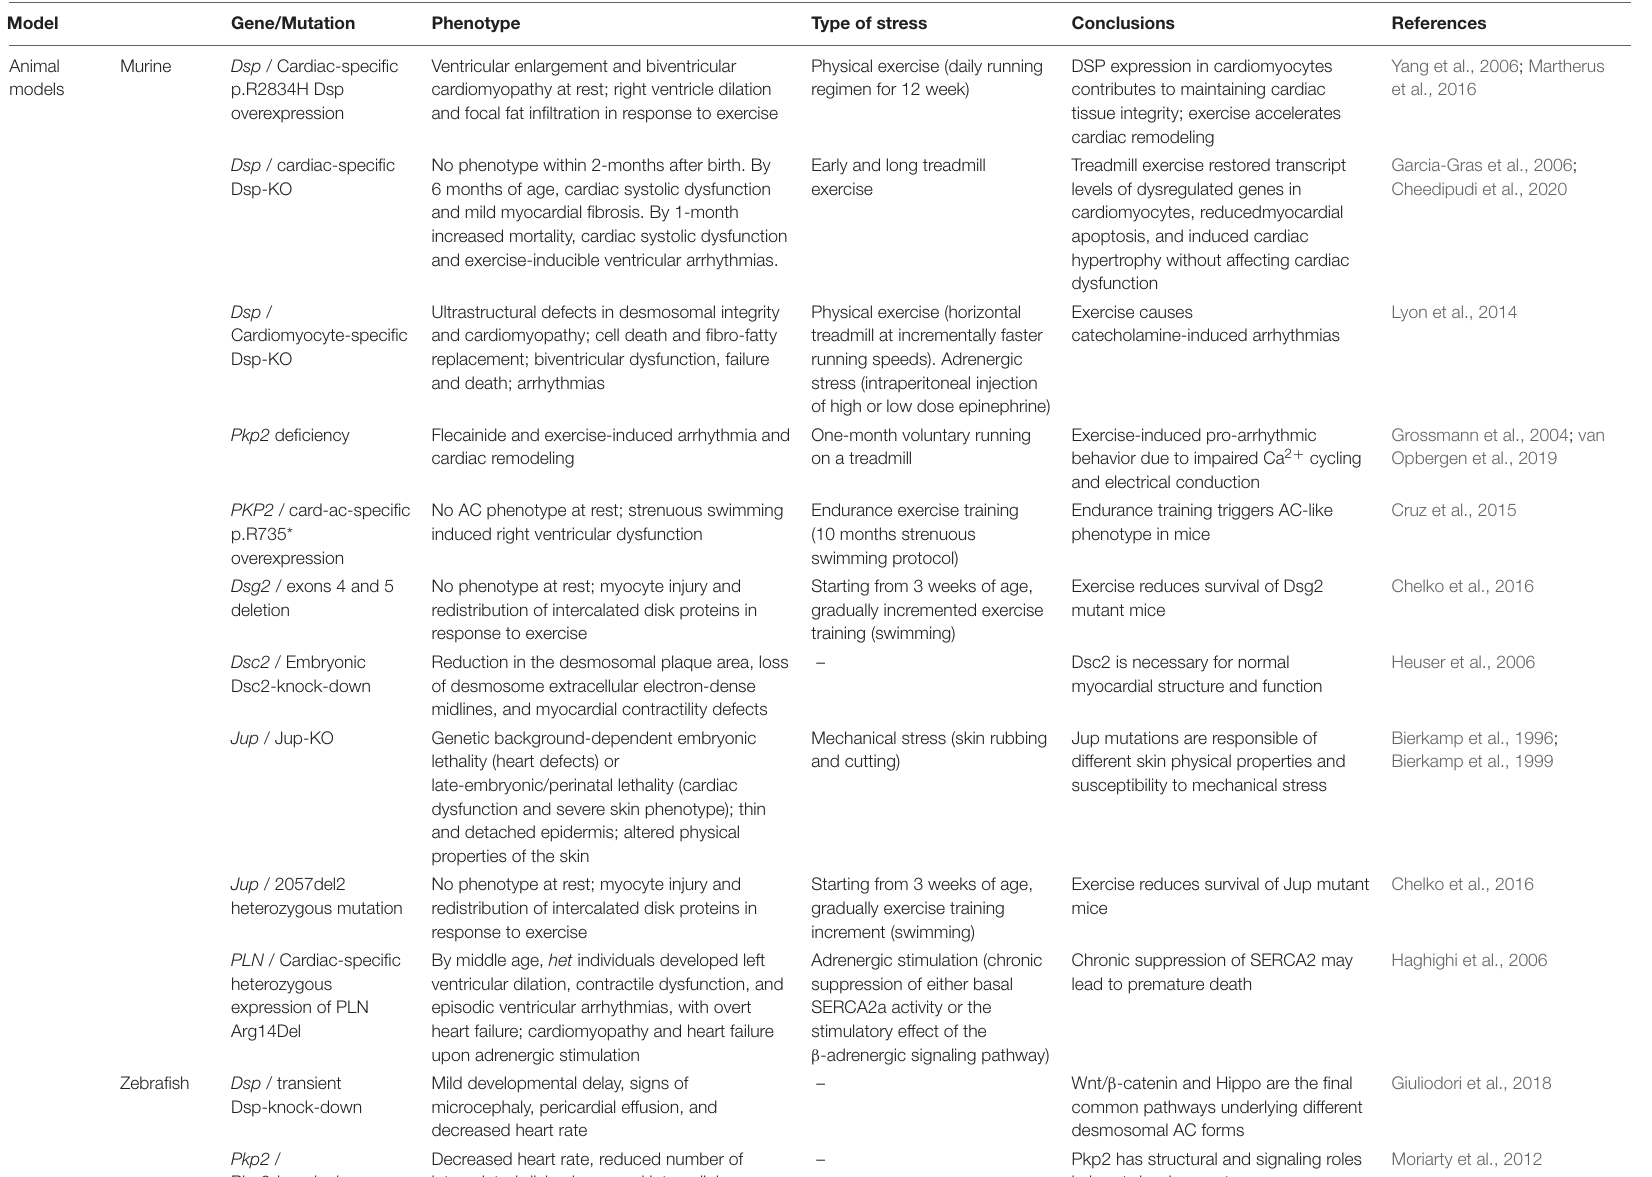
TABLE 3 | Animal and cellular AC models linking mechanical load/mechanotransduction and adrenergic stimulation with AC